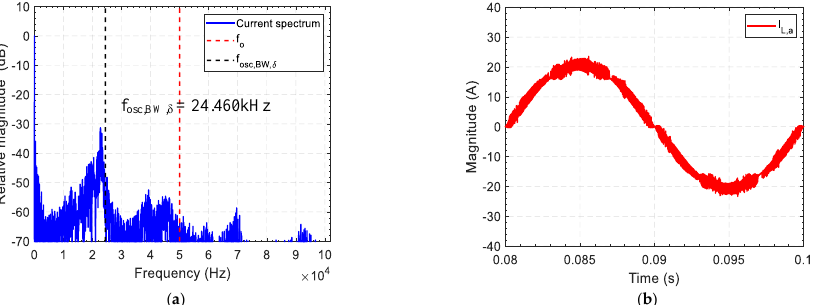
Figure 21. Simulation results under DPSSOCC control with experimental parameters: ( a ) current spectrum and ( b ) input current.